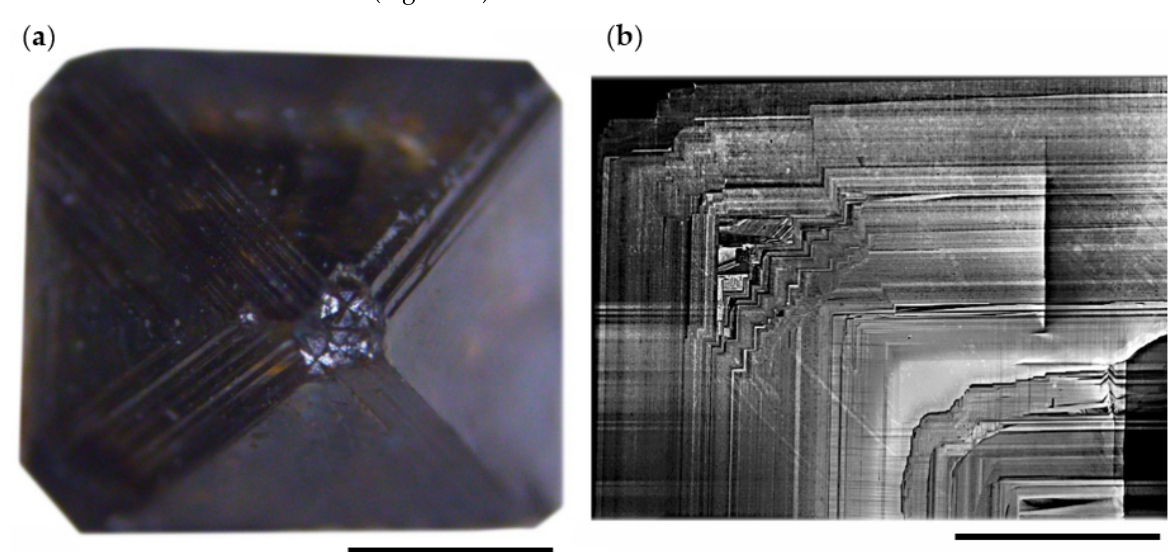
Figure 1. Flat ‐ faceted octahedral diamond crystal with a stepped structure of faces and tetragonal depressions at the vertices ( a ), the scale bar is 1 mm; CL image of cross ‐ section part from the center of this crystal in <100> direction ( b ), the scale bar is 0.3 mm.